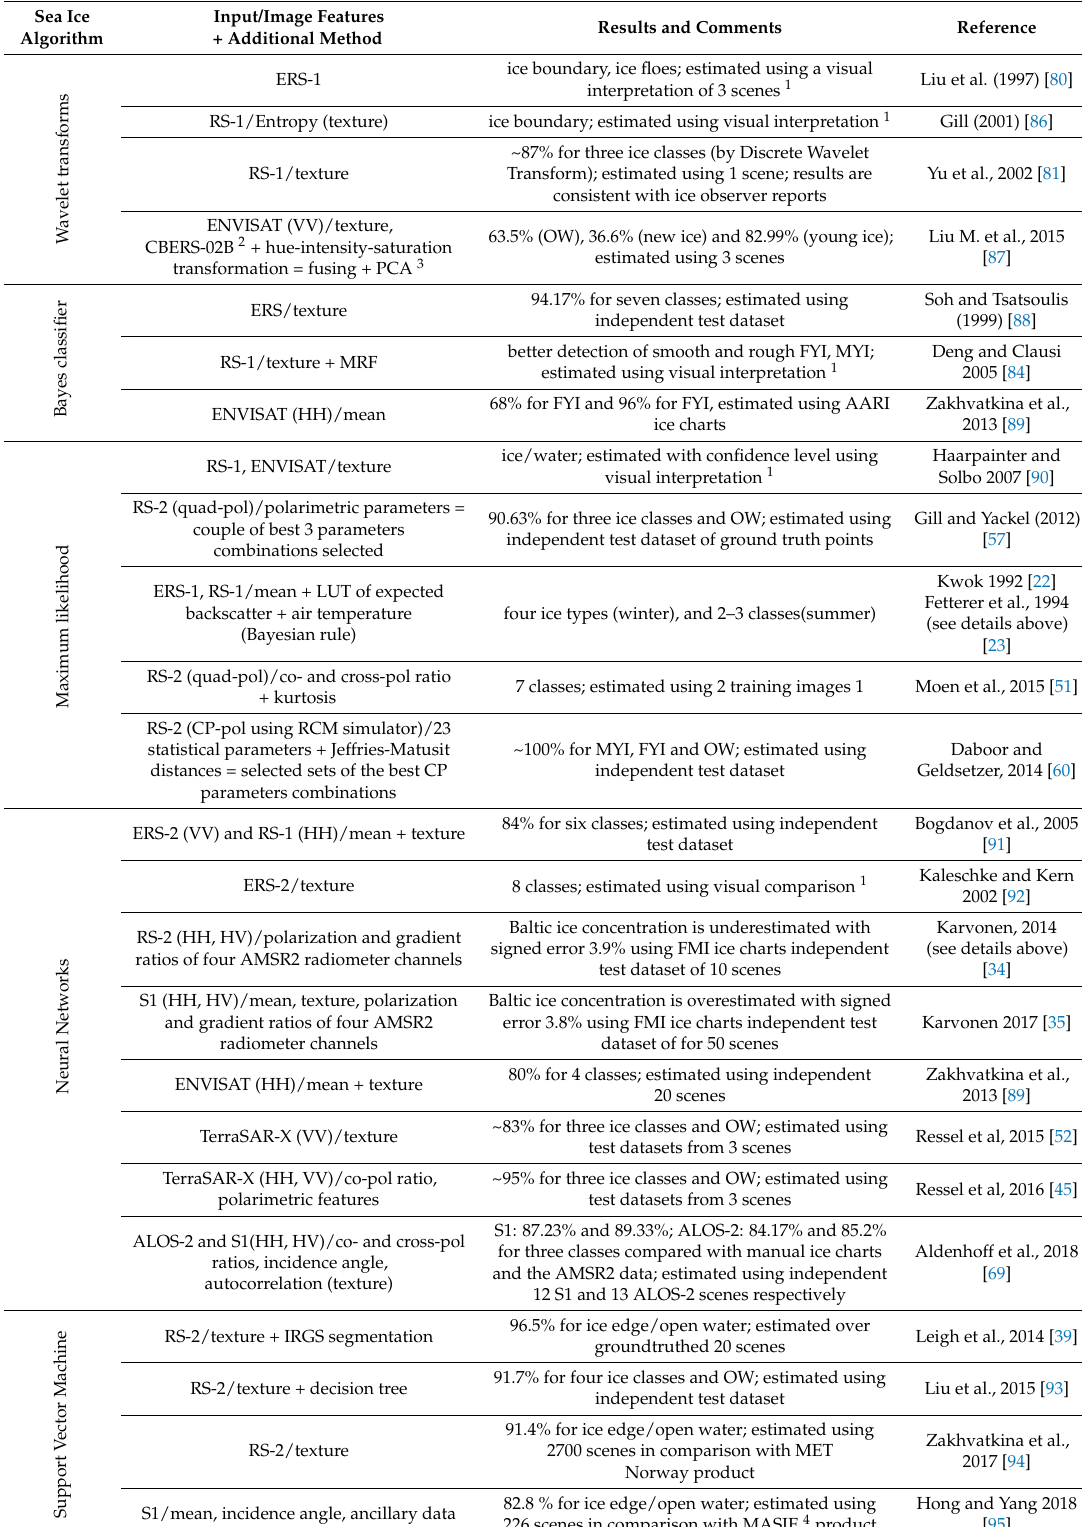
Table 1. SAR data-based methods for sea ice